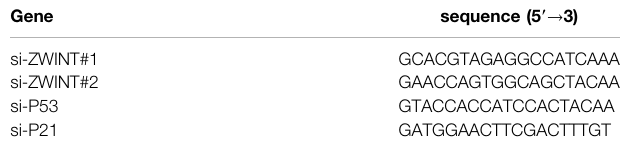
TABLE 2 | The siRNA sequence used in the transfection